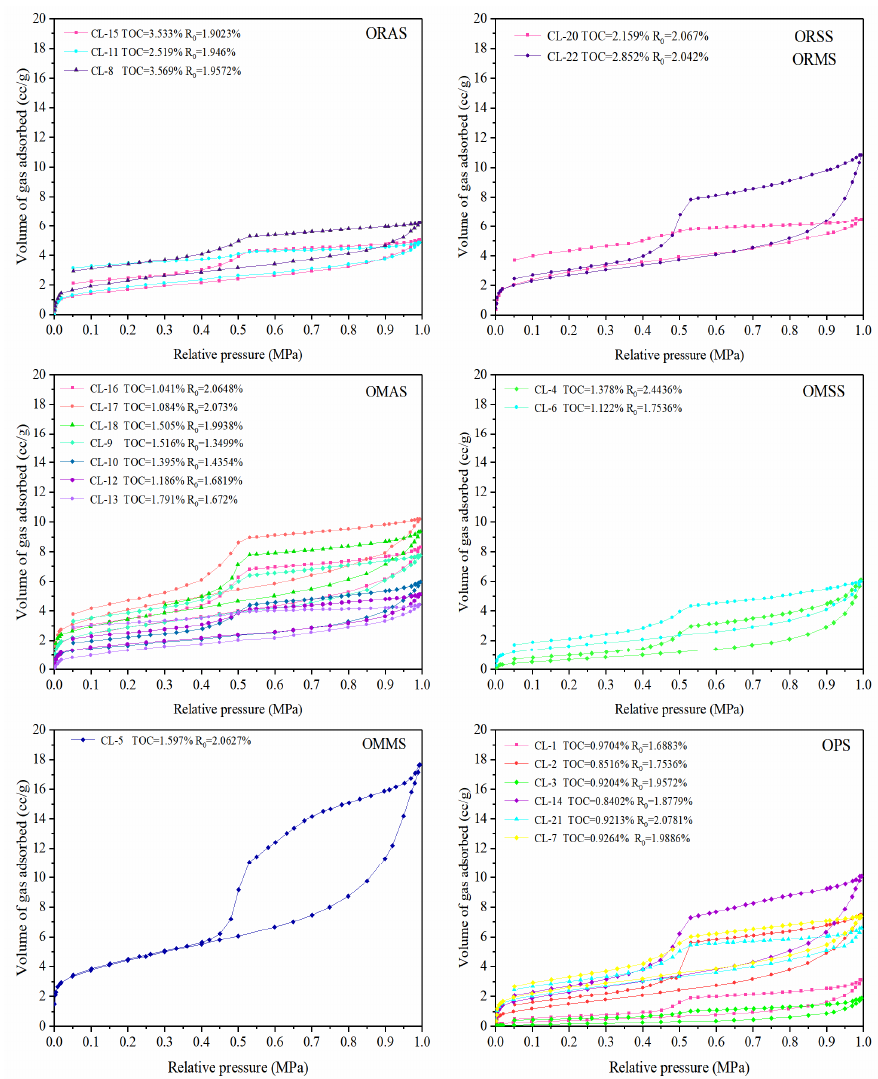
Figure 6. Low pressure nitrogen physisorption (LPNP) isotherms of the Shahezi shales with different lithofacies in CFD.